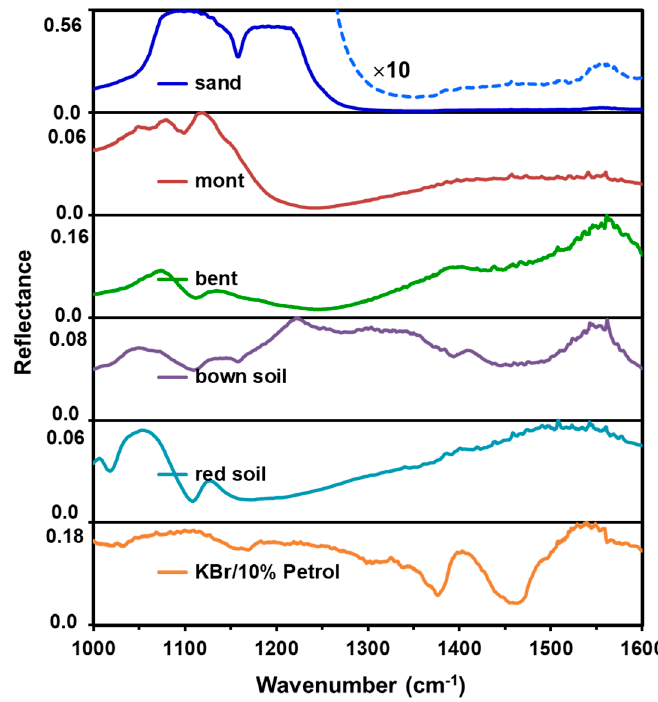
Figure 1. Representative reflectance spectra of the various samples without petroleum contaminants: sea sand (sand), montmorillonite (mont), bentonite (bent), brown soil, red soil, and KBr / 10%-Petrol reference sample.